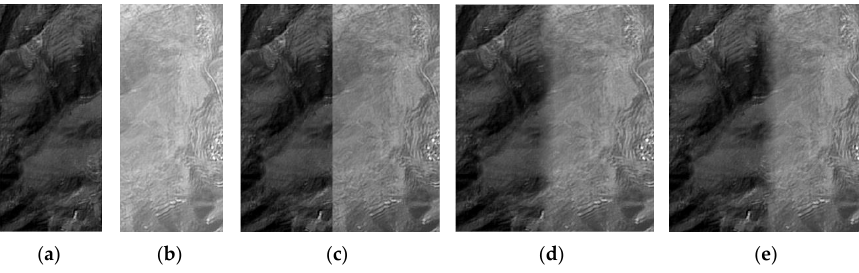
Figure 2. Image mosaicking results: ( a ) original left image; ( b ) original right image; ( c ) image mosaicked directly; ( d ) image mosaicked with the bisector of the overlapping region as the seam line; and ( e ) image mosaicked with the optimal seam line.